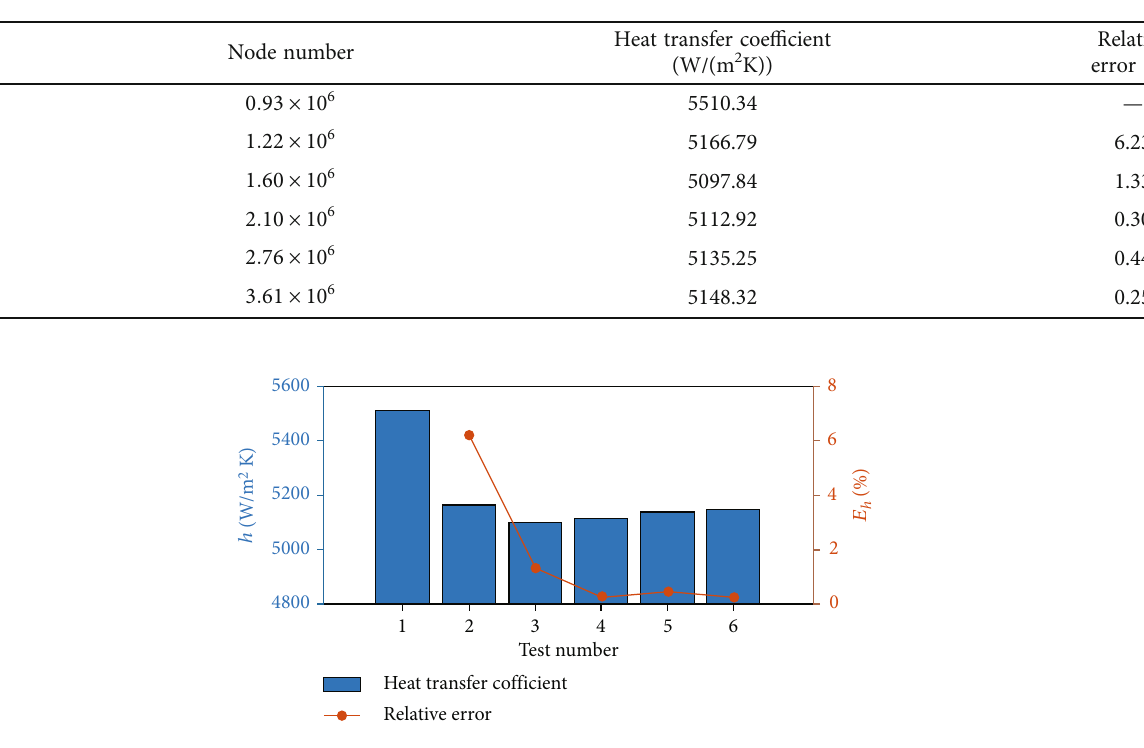
Table 1: The heat transfer coe ffi cient and its relative error on the blade